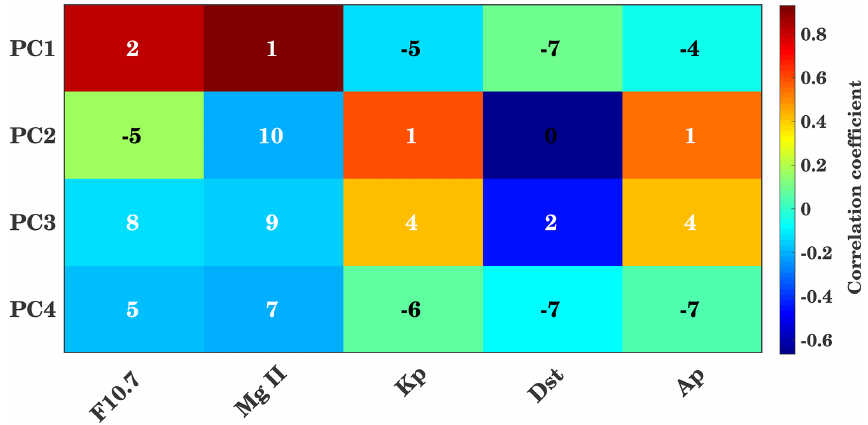
Figure 14. Maximum correlation coefficients and the time lag between the PCs and solar and magnetic proxies for the 25–35d interval. Background colors show the maximum correlation coefficients, and the inserted numbers show the delay in days corresponding to maximum